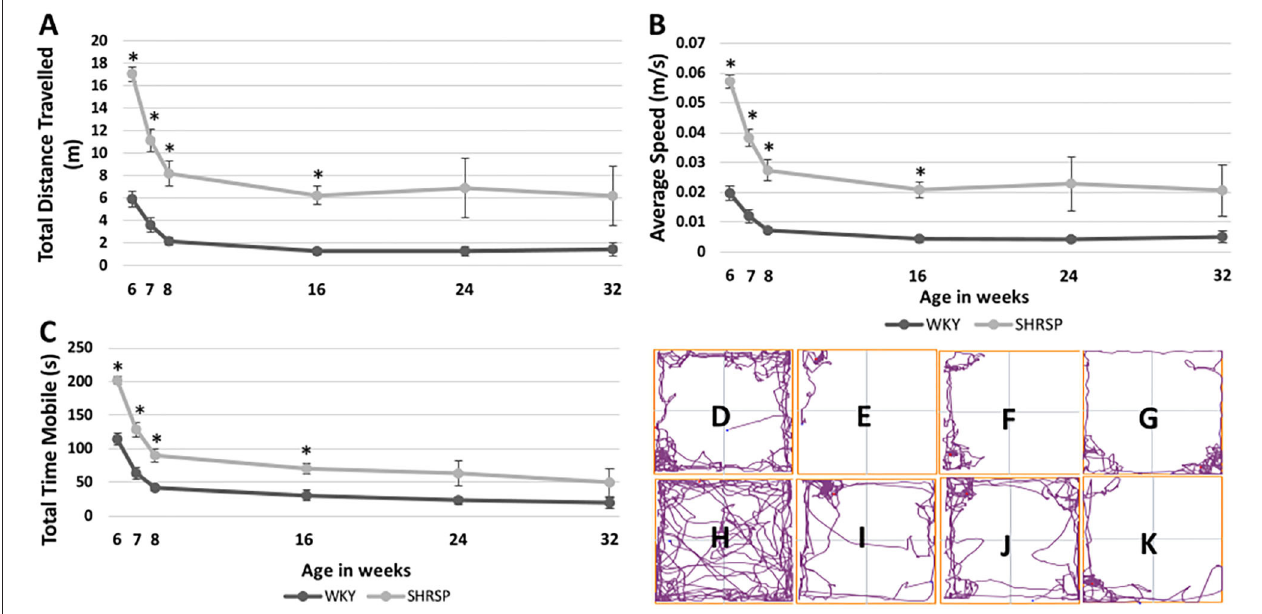
FIGURE 2 | Temporal changes of sensorimotor testing in WKY and SHRSP presented at 6, 7, 8, 16, 24, and 32 weeks of age. Compared to WKY, SHRSP were found to have motor restlessness as represented by a longer total distance traveled during the testing period (A) , higher average speed (B) and longer total mobile time (C) . The differences between SHRSP and WKY, were statistically significant at 6, 7, 8, and 16 weeks of age while they became not statistically different afterwards. Head tracing of one WKY at [6 (D) , 16 (E) , 24 (F) , and 32 (G) weeks of age] and one SHRSP at the same time points [6 (H) , 16 (I) , 24 (J) , and 32 (K) ] weeks of age is shown which visually demonstrates larger decrease in activity during the experiment in SHRSP compared to WKY. WKY, Wistar Kyoto Rats; SHRSP, Spontaneously Hypertensive Stroke-Prone Rats; m: meter; s, second, m/s, meter per second; * , statistically significant difference of P <